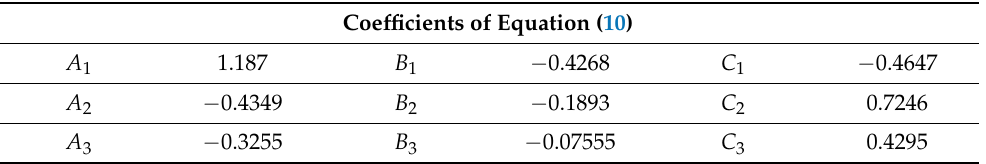
Table 1. Coefficients for the fitting equation given in Equation